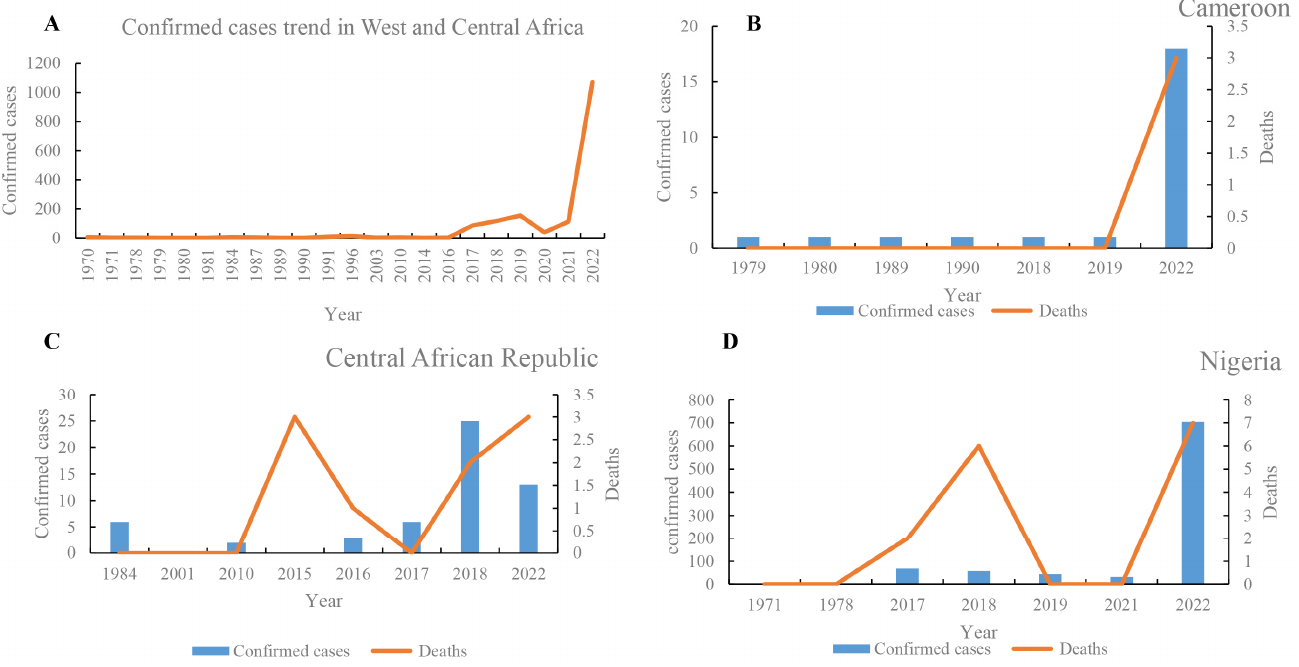
Figure 2. Comparative analysis of trends of mpox cases in West and Central Africa. Confirmed cases trends of mpox cases in West and Central Africa ( A ), and Cameroon ( B ), Central African Republic ( C ), and Nigeria ( D ), respectively.